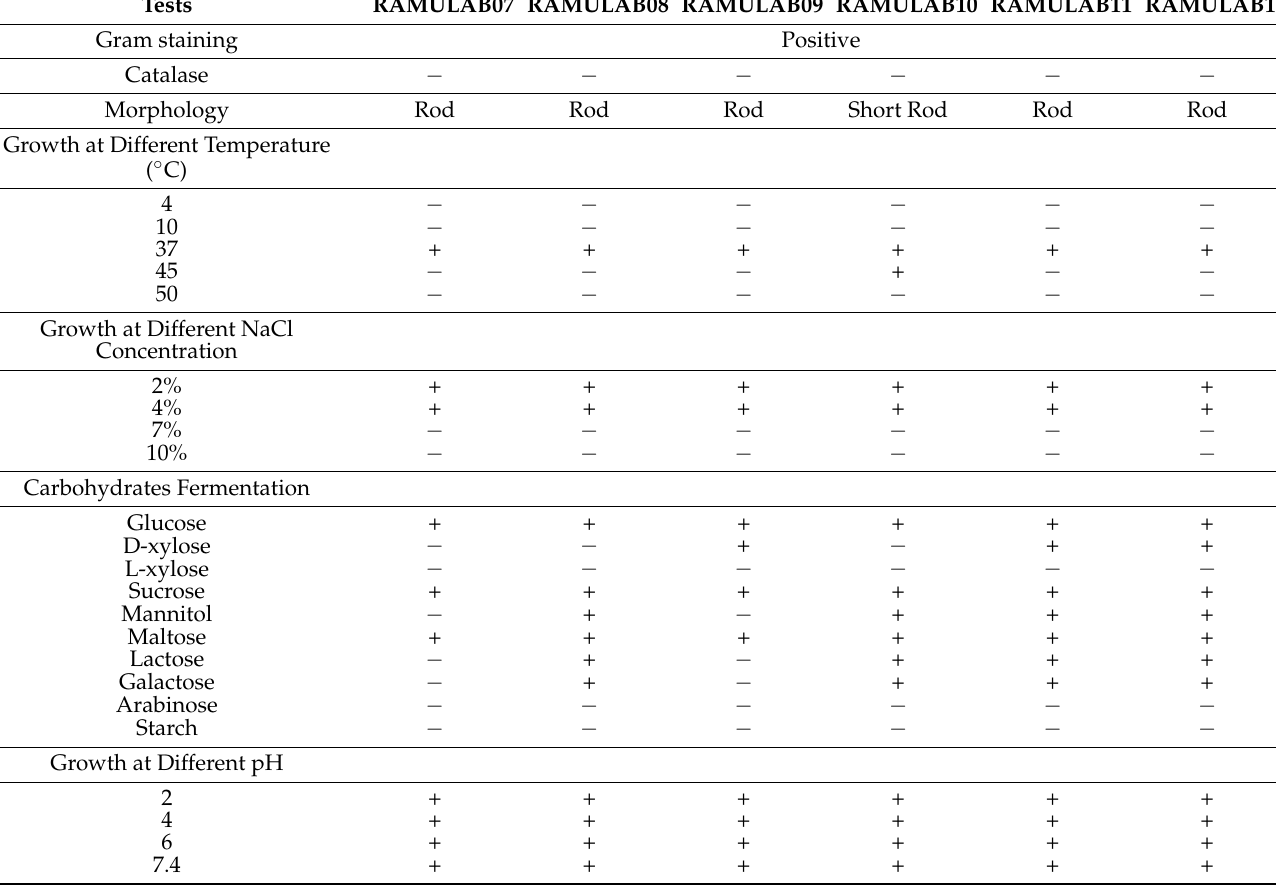
Table 1. LAB strains isolated from dosa batter sample were studied for their phenotypic characteristics and fermentation ability.